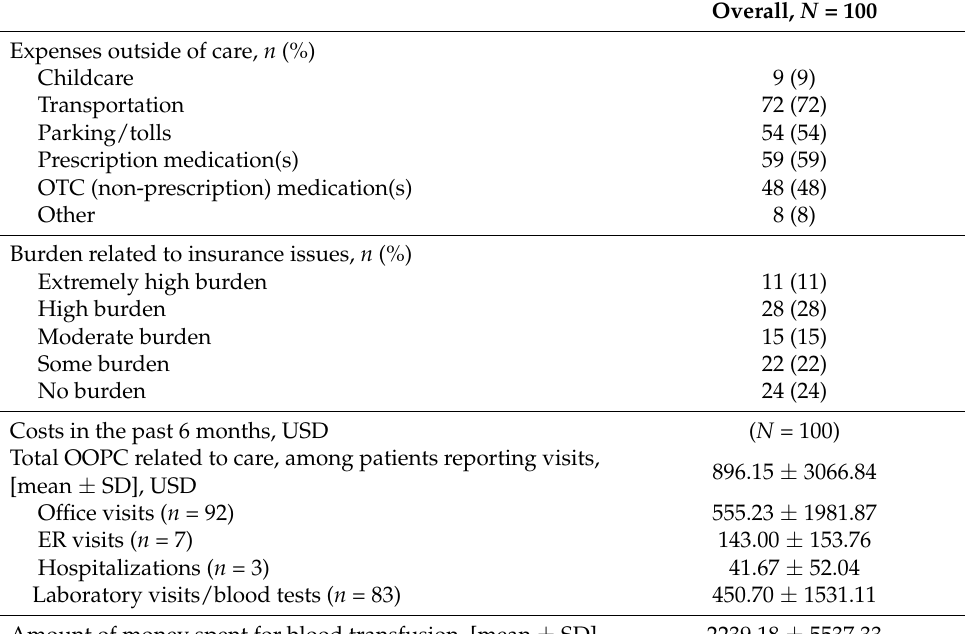
Table 4. Direct and indirect costs including 6-month